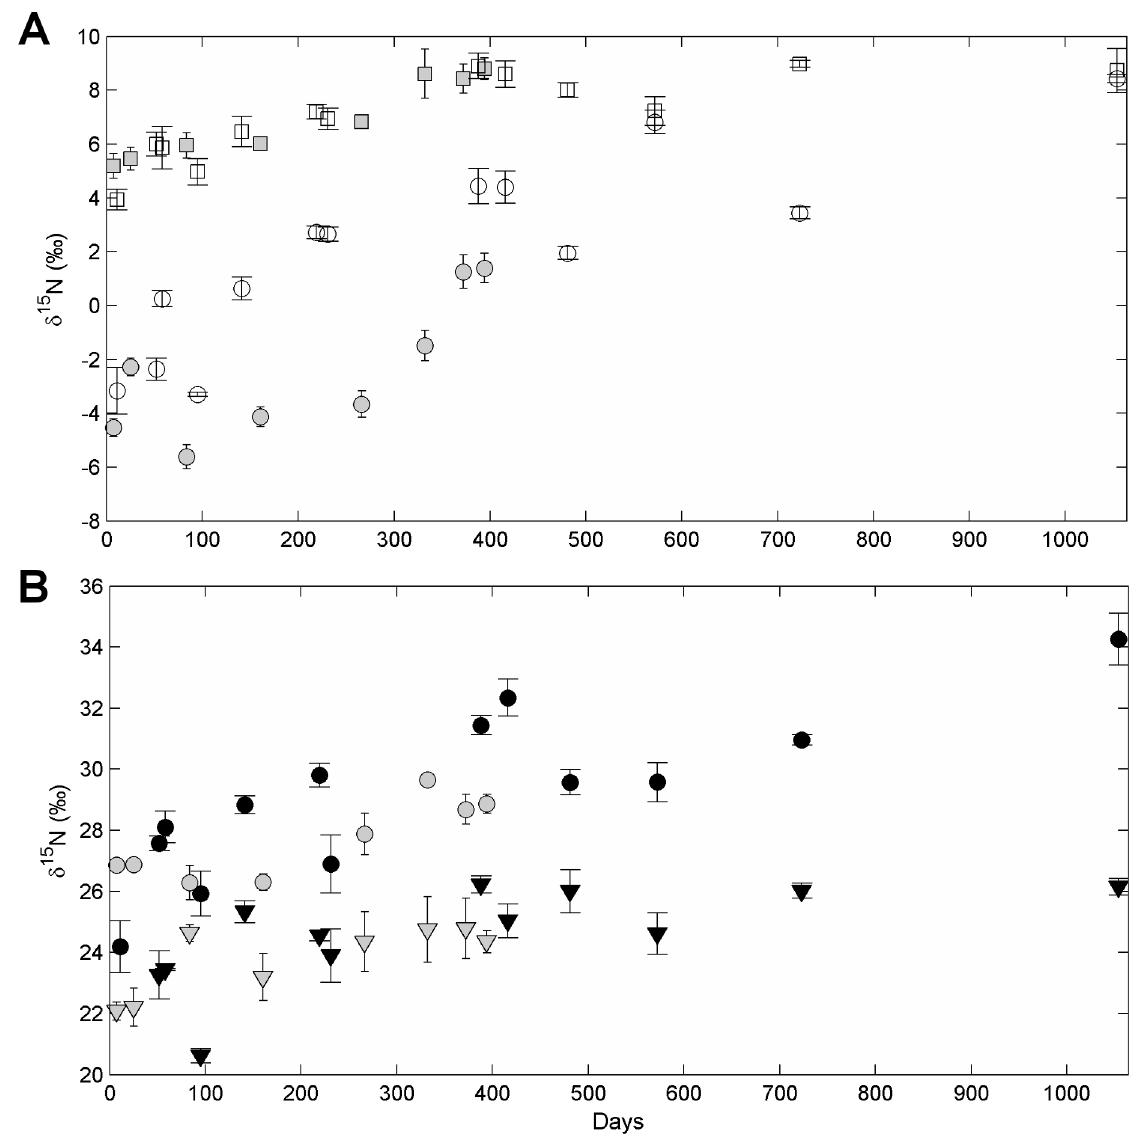
Figure 5. Comparison of amino acid isotopic composition in wild and captive Pacific bluefin tuna ( Thunnusorientalis ). Change in d 15 N values of amino acids of white muscle tissue with time following a natural diet shift. A) Two source amino acids, glycine (unfilled circle), lysine (unfilled square), and B) two trophic amino acids - alanine (filled circle), proline (filled inverted triangle) are given. Wild samples are shown as grey shaded